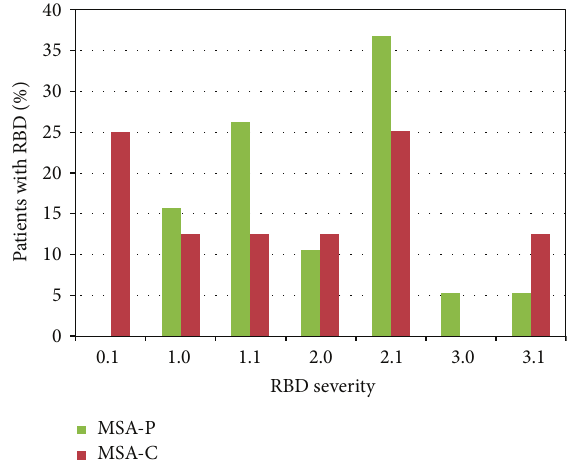
Figure 2: Representation of MSA patients according to RBD sever- ity evaluated with RBDSS. RBSS = REM sleep behavior disorder severity scale, MSA-C = multiple system atrophy cerebellar predom- inant,MSA-P=multiplesystematrophyparkinsonianpredominant. with MSA-P. There was no difference in the incidence as well as in the severity of clinical RBD between the two groups ( 𝑃 = 0.849 ). Violent manifestations were noted in only two of the MSA-P and one of the MSA-C patients. Details of RBD severity are represented in Figure